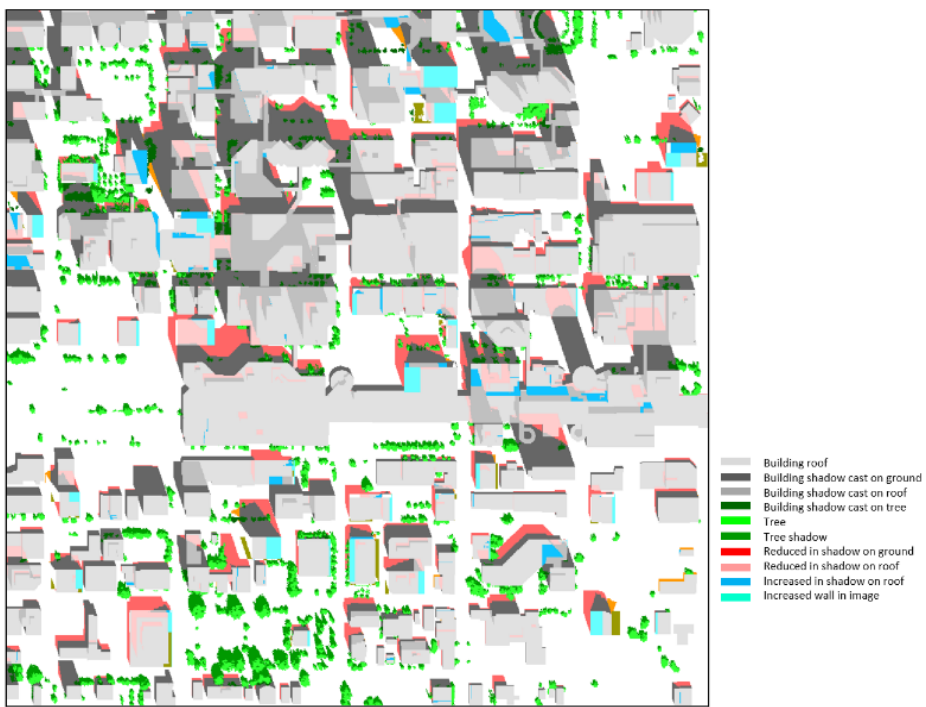
Figure 14. Class map of shadow differences before and after damages derived from building damage case shown in Figure 13.